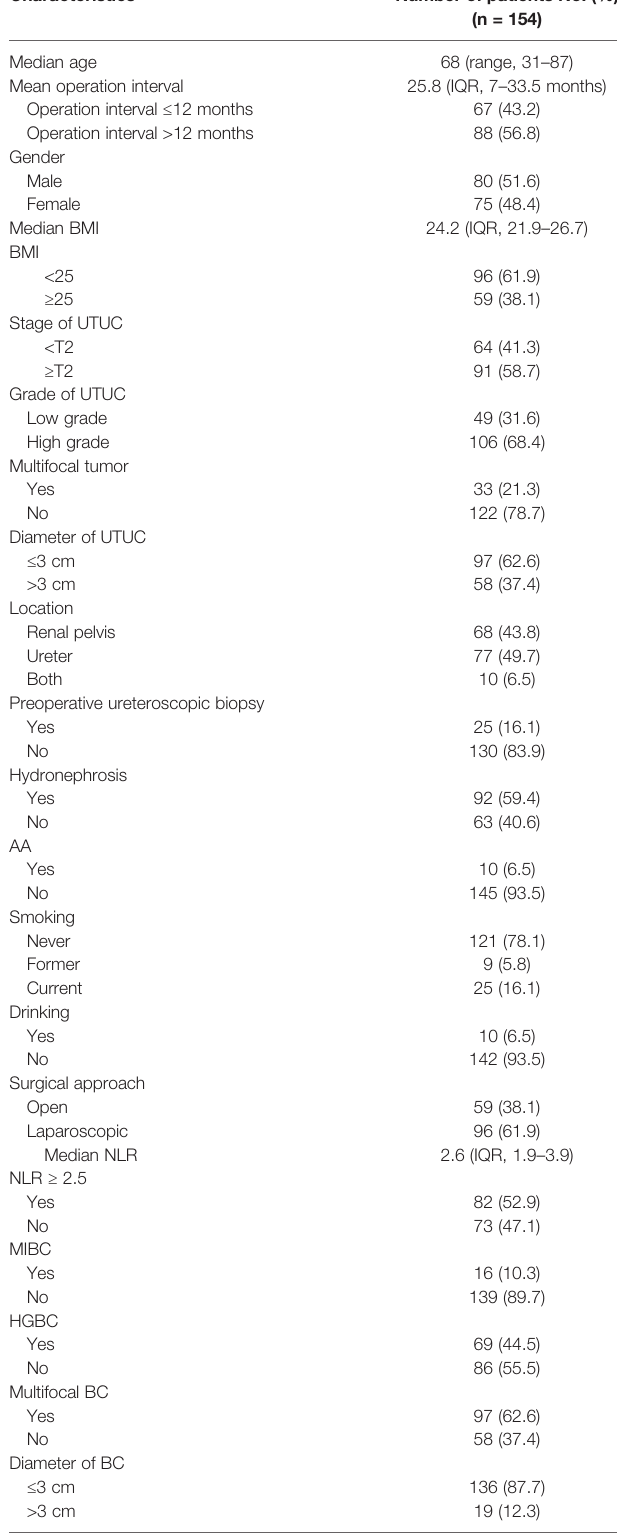
TABLE 1 | Clinicopathologic characteristics of patients.